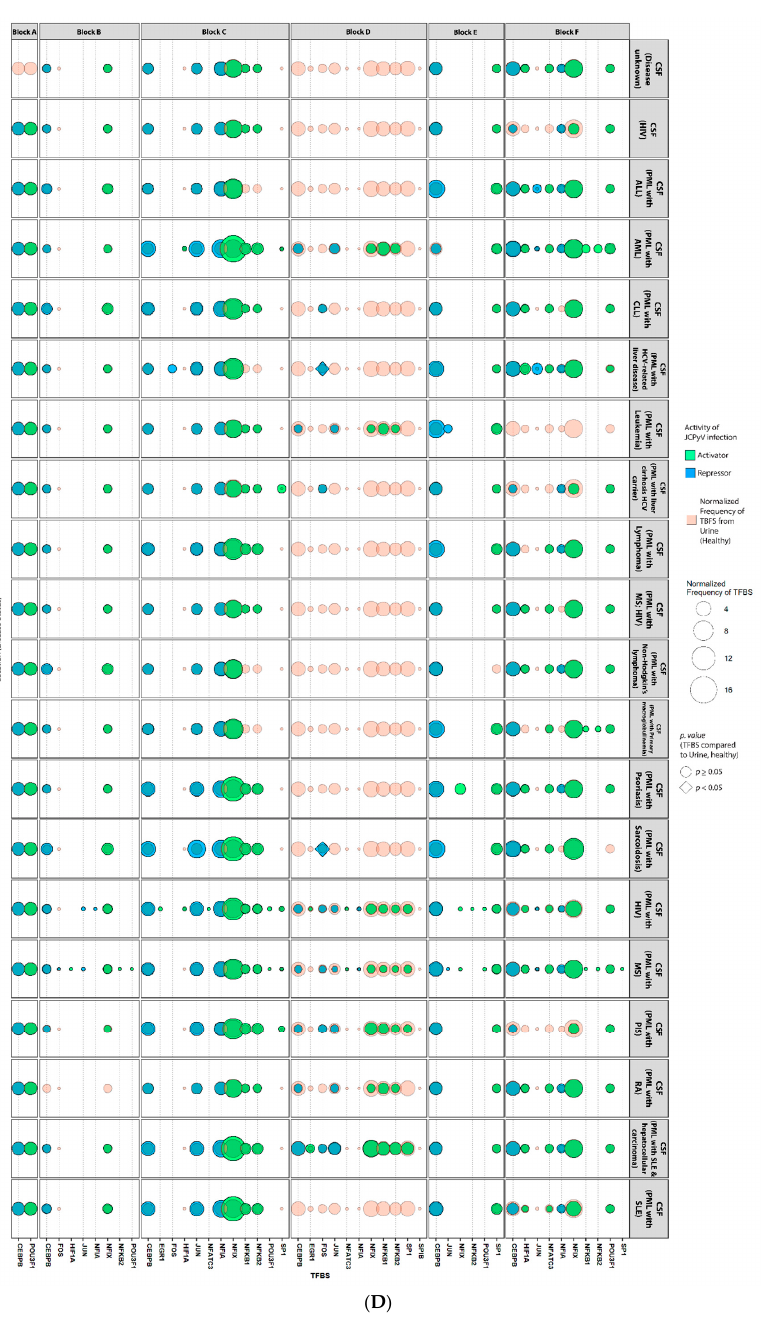
Figure 2. Transcription factors binding sites that are known to activate JCPyV infection are more prevalent in the NCCR of viral isolates from the brain, plasma, and especially, the CSF in patients that have PML or AIDS. The R package, ‘TFBStools’ was used to determine the TFBS for each block, using the 2020 JASPAR database. Known TFBS that have are associated with JCPyV transcription and replication were illustrated as a balloon plot using ‘ggplot2’. TFBS are faceted by the 6 blocks (A–F), disease status, and by tissue source: urine ( A ), blood ( B ), brain ( C ), and CSF ( D ). The size of the shape represents the normalized frequency of the TFBS (i.e., the number of times the TFBS is present) [(# of TFBS/Block)/(# of sequences)] in each of the 6 groups/locations and the color represents the activity that correlates with JCPyV infection. Sequences isolated from the blood represent serum, plasma, and PBMC sequences. Unadjusted p values were determined by Fisher’s exact test to compare the normalized frequency of TFBS (size of shapes) from the Urine (Healthy) to all other